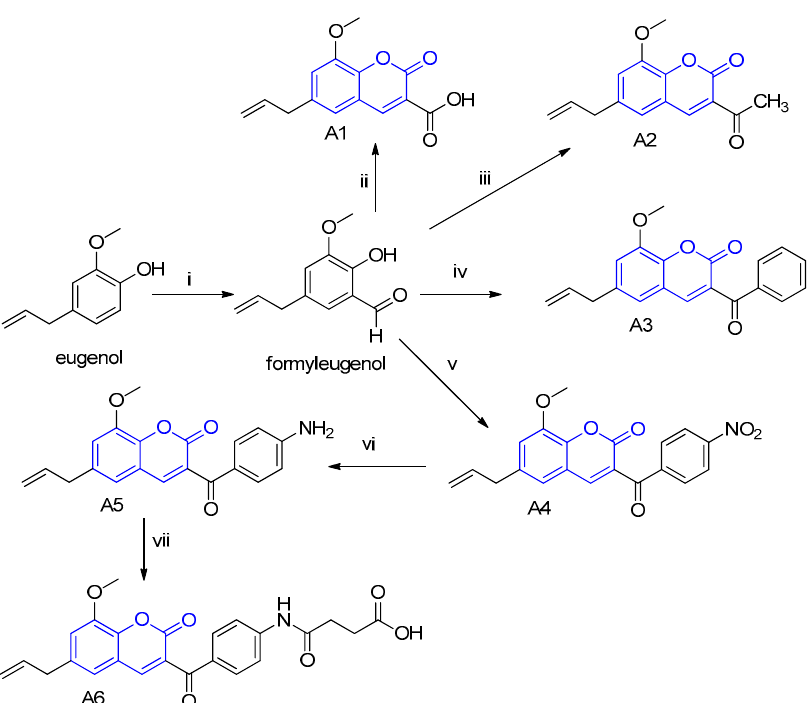
Figure 6. Synthetic route employed to obtain coumarins A1–A6 from eugenol: (i) hexamine, glacial acetic acid, 140 °C, followed by hydrolysis with aqueous HCl; (ii) malonic acid, piperidine, ethanol, 80 °C; (iii) ethyl acetoacetate, piperidine, ethanol, 80 °C; (iv) ethyl benzoylcetate, piperidine, ethanol, 80 °C; (v) ethyl 4-nitrobenzoylcetate, piperidine, ethanol, 80 °C; (vi) tin chloride, ethanol, reflux; (vii) succinic anhydride, pyridine, 80 °C. The coumarin chemical names are as follows: Coumarin A1 : 8-